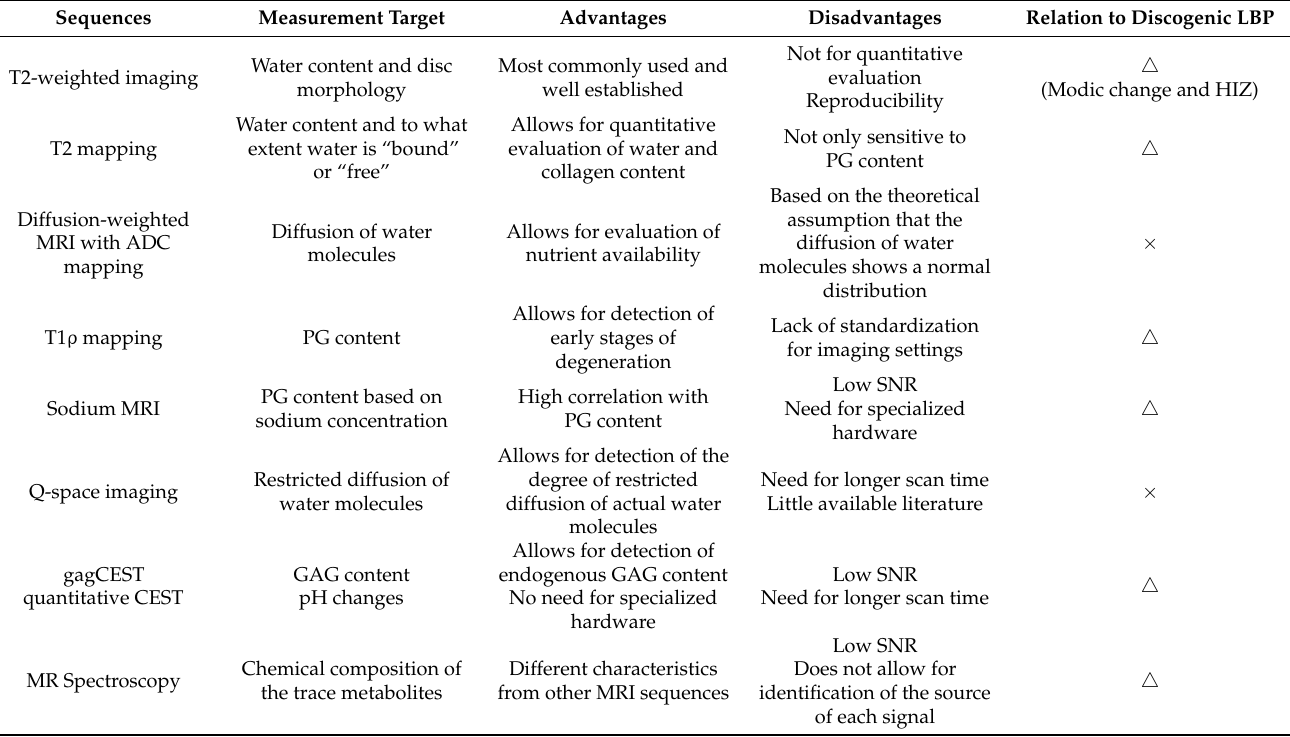
Table 1. Summary of the characteristics of various MRI sequences as imaging diagnostic tools for IVD degeneration and painful